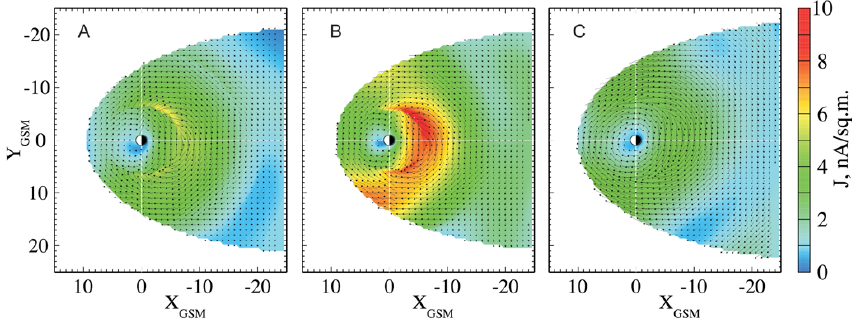
Fig. 10. Equatorial plots of the electric current density, derived from the TS07D modelling of the storm of 21–23 April: early main phase (A) , peak of the main phase (B) , early recovery phase (C)